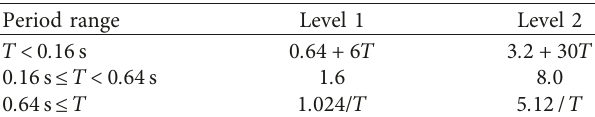
Figure 3: G s factor (Japan). Table 5: Spectral acceleration in bedrock ( S 0 ) according to the Japanese code (m/s 2 ) [19].